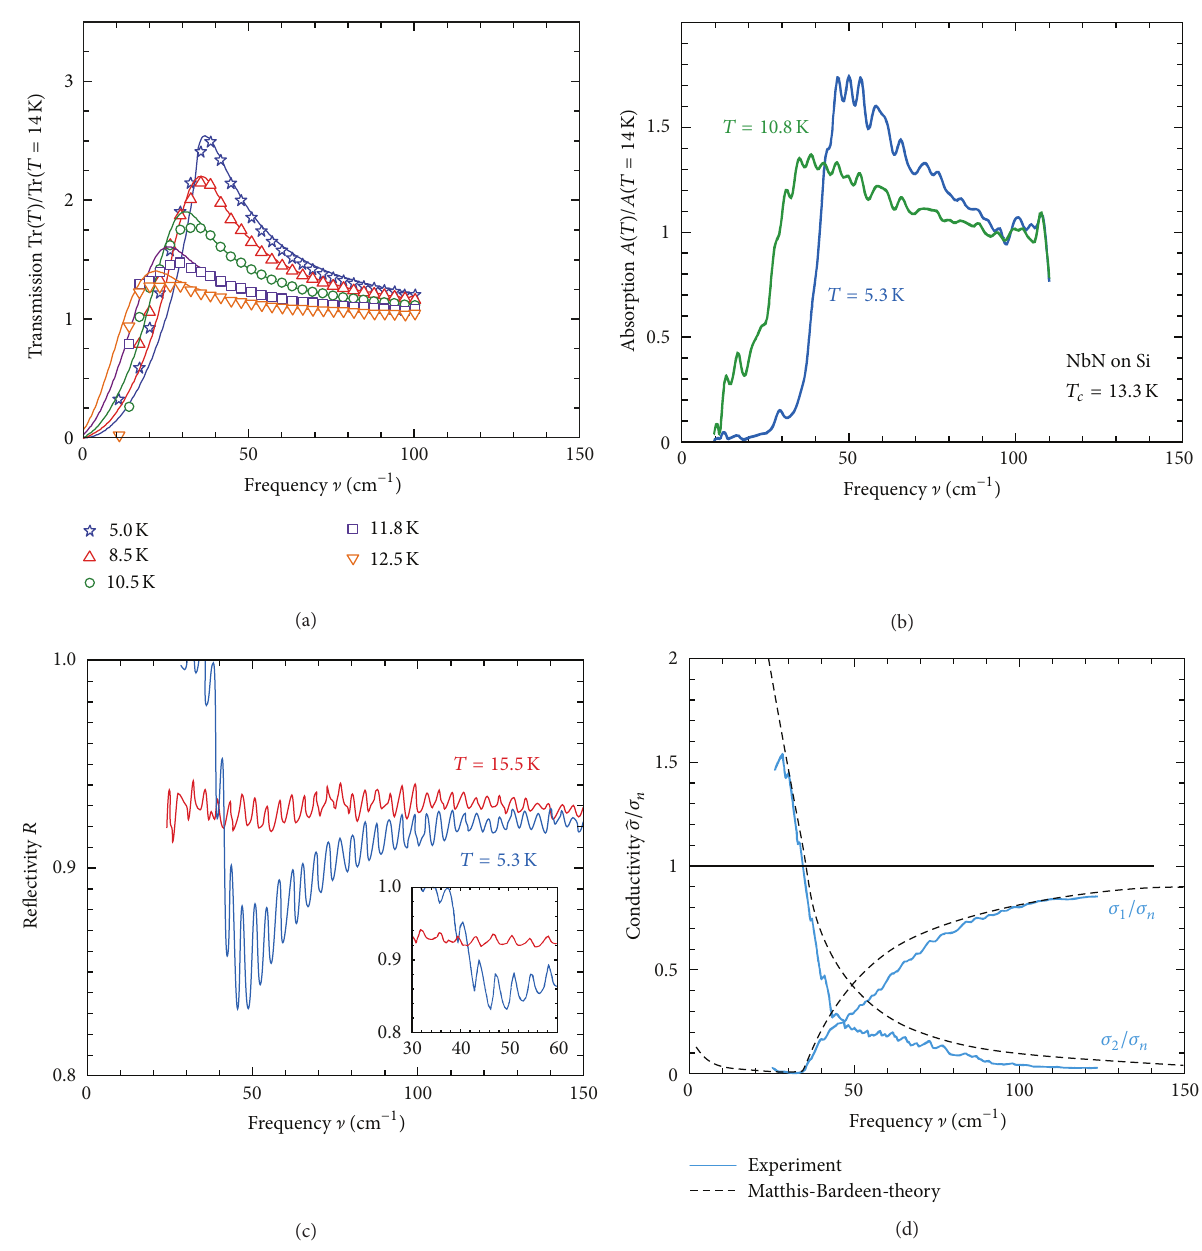
Figure 10: (a) Ratio of the infrared transmission through a NbN film in the superconducting state and the normal state for several temperatures; the critical temperature of this film is 𝑇 𝑐 = 13.5 K (after [84]). (b) The bolometric absorption spectra of a superconducting NbN film at different temperatures below 𝑇 𝑐 = 13.3 K ratioed with a 14K spectrum above 𝑇 𝑐 . The curves have been scaled individually to agree at 110cm −1 (for the purpose of comparison) and overall to give a 5.3 K spectrum, which equals 1.0 at large wave numbers. The resolution is 2 cm −1 . (c) Optical reflectivity of a 250 nm NbN film on silicon ( 𝑑 = 0.39 mm) above and below the superconducting transition temperature. The resolution was 0.5 cm −1 below 100cm −1 and 2cm −1 above. The inset gives the low-frequency part on a magnified scale in order to demonstrate the shift of the Fabry-Perot resonance pattern: At high frequencies the reflection maxima are in phase, but, for low frequency, the reflectivity in the superconducting state exhibits minima where maxima are observed for 𝑇 > 𝑇 𝑐 . (d) Real and imaginary parts of the conductivity at 𝑇 = 5.3 K normalized to the normal state value, as extracted from the reflection data shown above. The dashed lines correspond to the calculations based on Mattis-Bardeen theory, yielding an energy gap 2Δ/ℎ𝑐 = 34.5 cm −1 (after